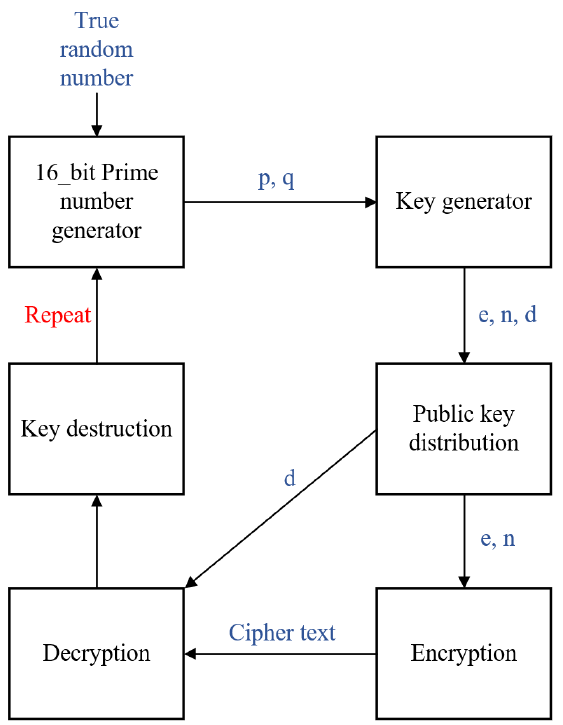
Figure 4. Proposed RSA encryption